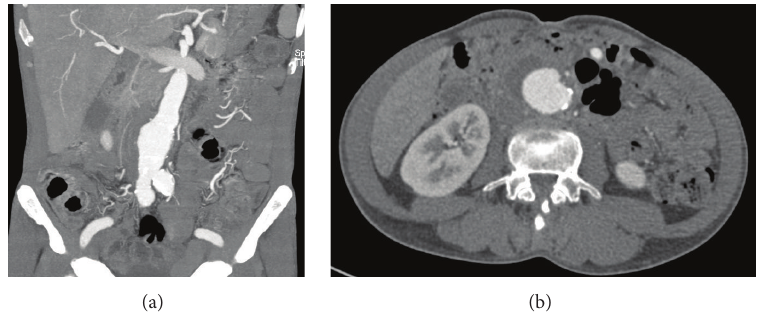
Figure 1: First patient: CTA abdomen. (a) Coronal section view of CTA: wall enhanced infrarenal AAA with periaortic tissue thickening and hematoma. (b) Cross-sectional view from CTA: blistering area of the aneurysm wall.